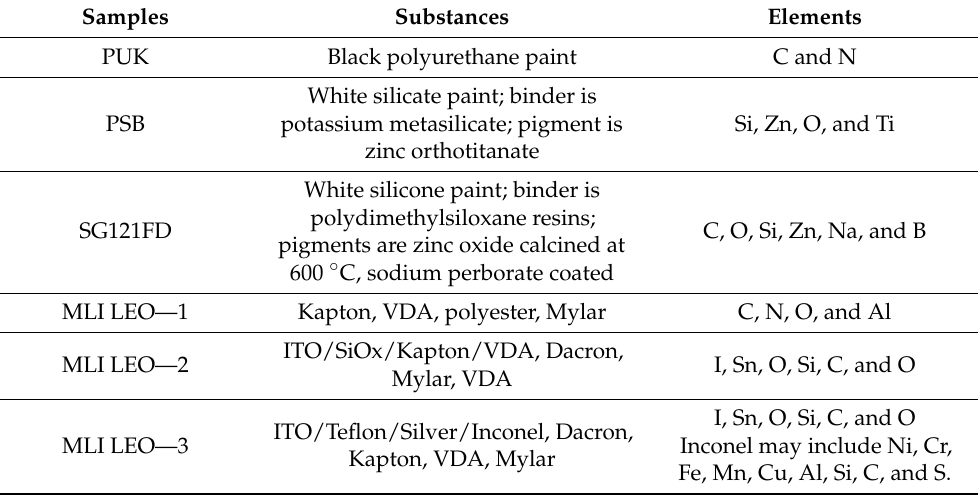
Table 8. LEO sample paints’ compositions.